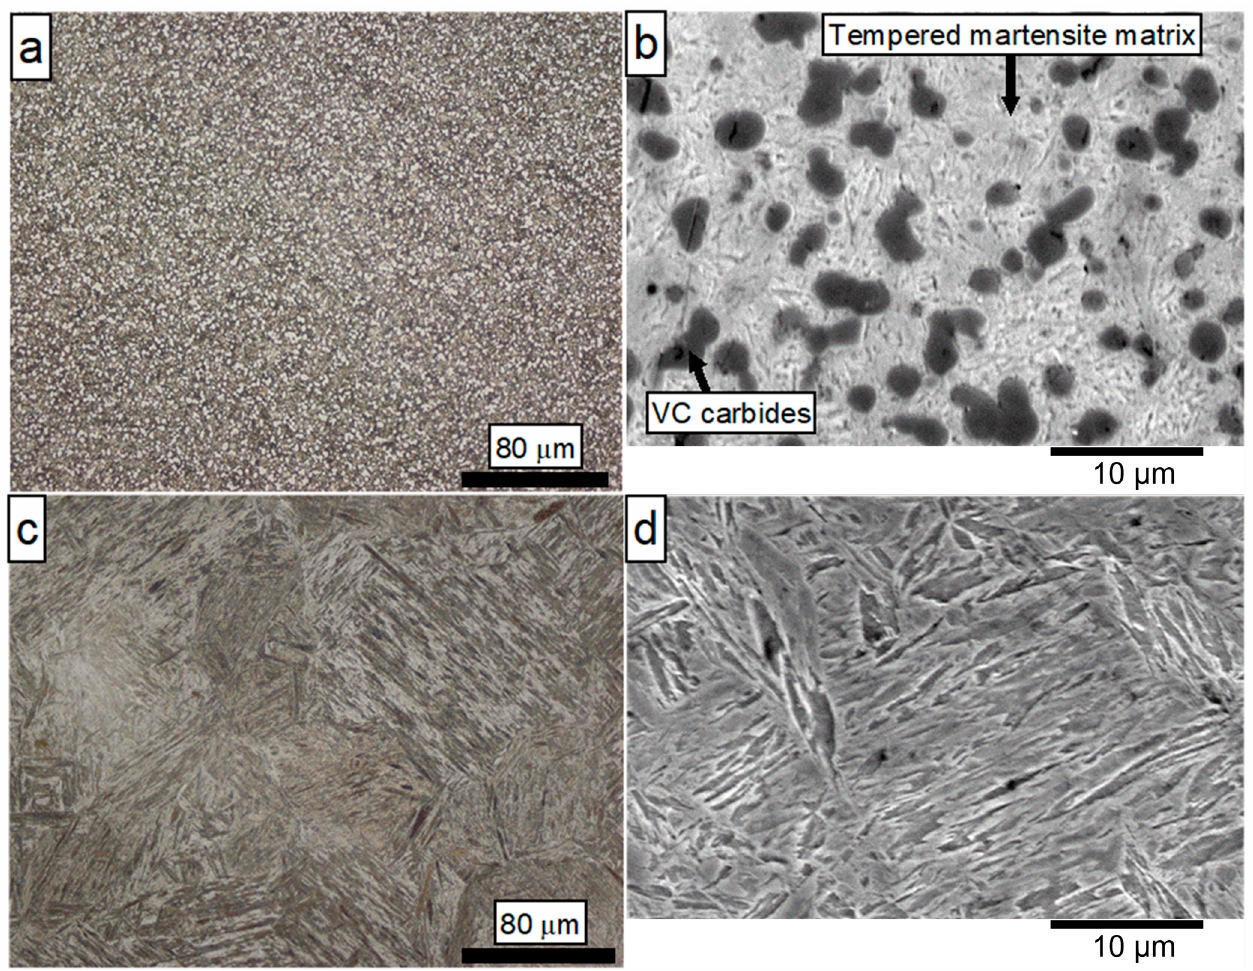
Figure 2. Microstructures of the materials used for the welding study: ( a , b ) the CPM 15V steel, and ( c , d ) shovel-tooth using optical microscopy and SEM, respectively.